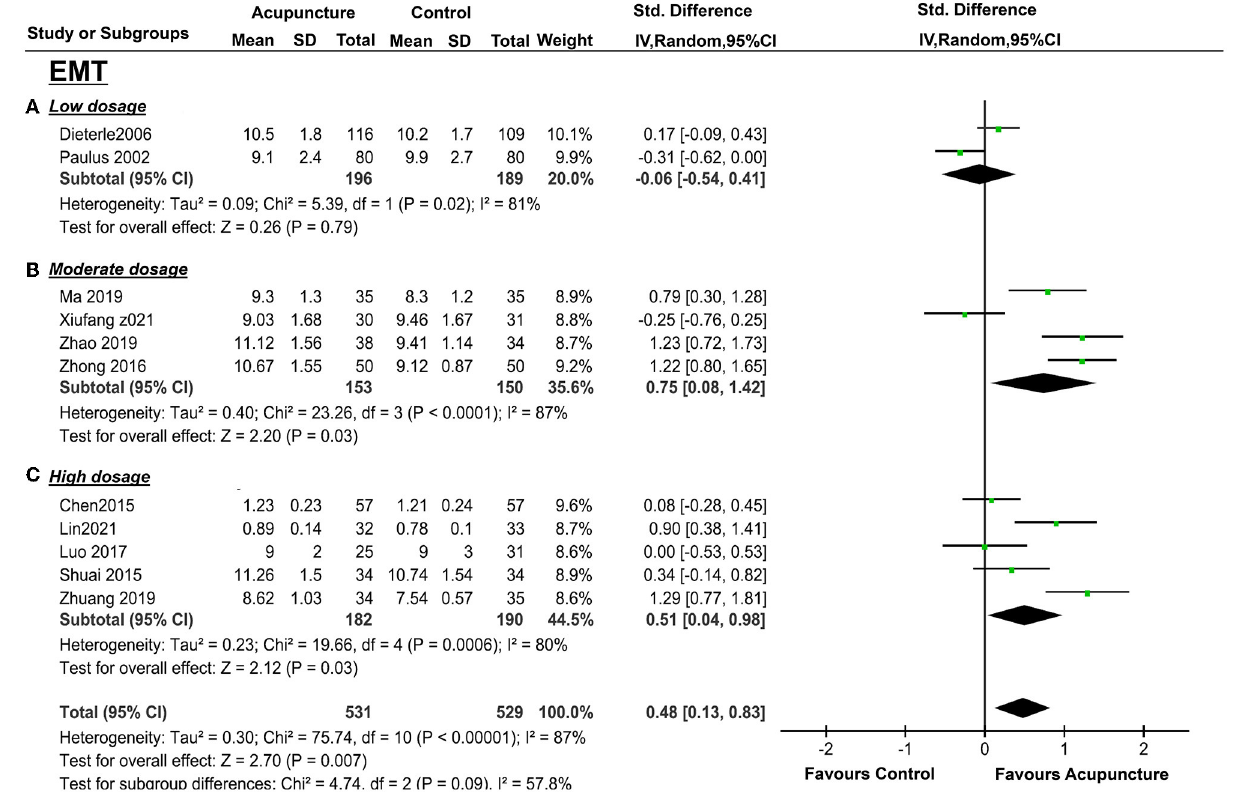
= 0.53 for clinical pregnancy outcome and interaction p =